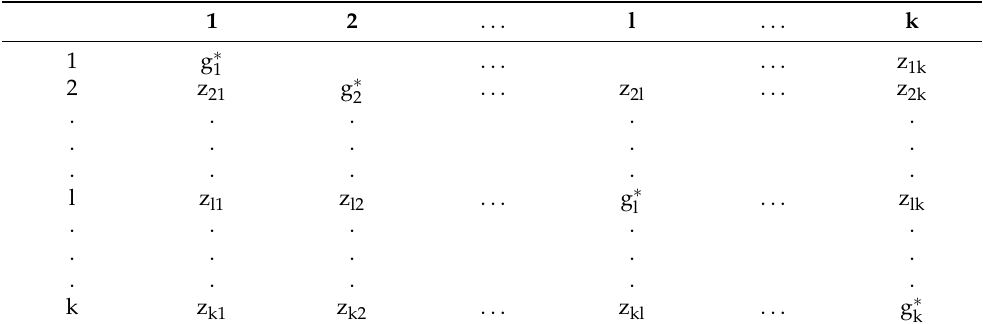
Table 1. The pay-off